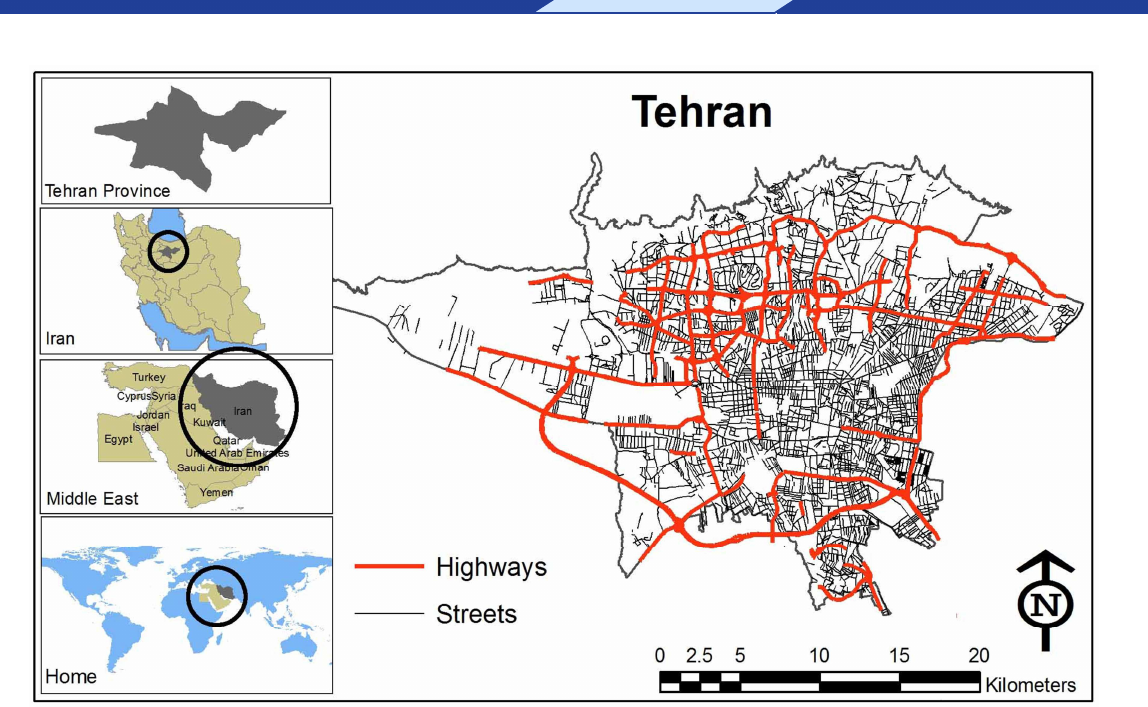
Figure 1. The study area of Tehran, Iran if it was negative, then the pattern is